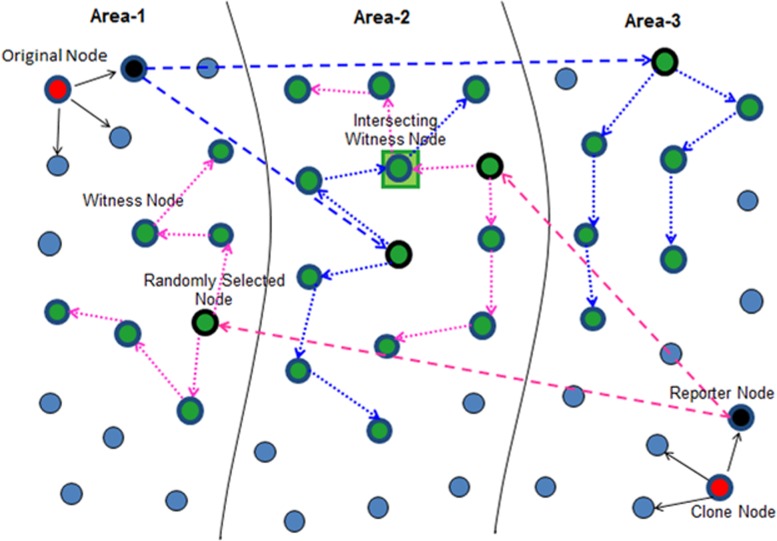
Working Principle of RAND [13, 14]